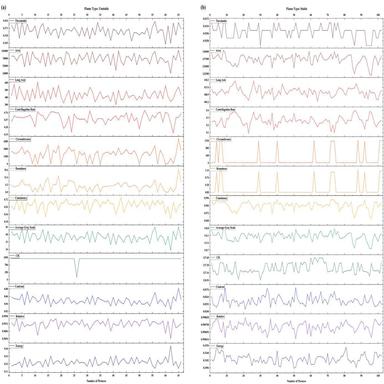
Characteristic values of different types of flames. (a) Unstable flame characteristic value; (b) Stable flame characteristic value; (c) Tempering flame characteristics; (d) Diffusion flame characteristic value.